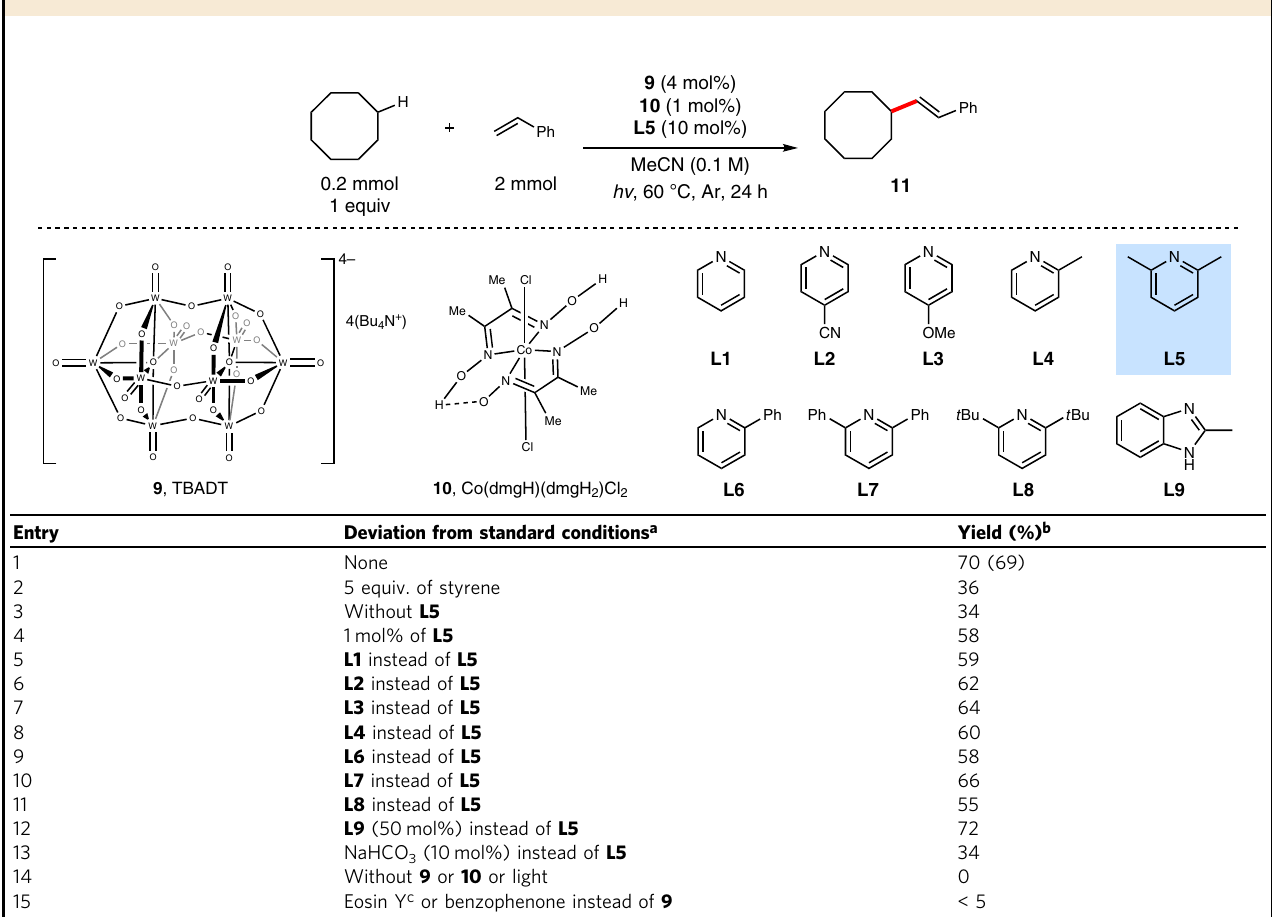
Table 1 Selected optimization